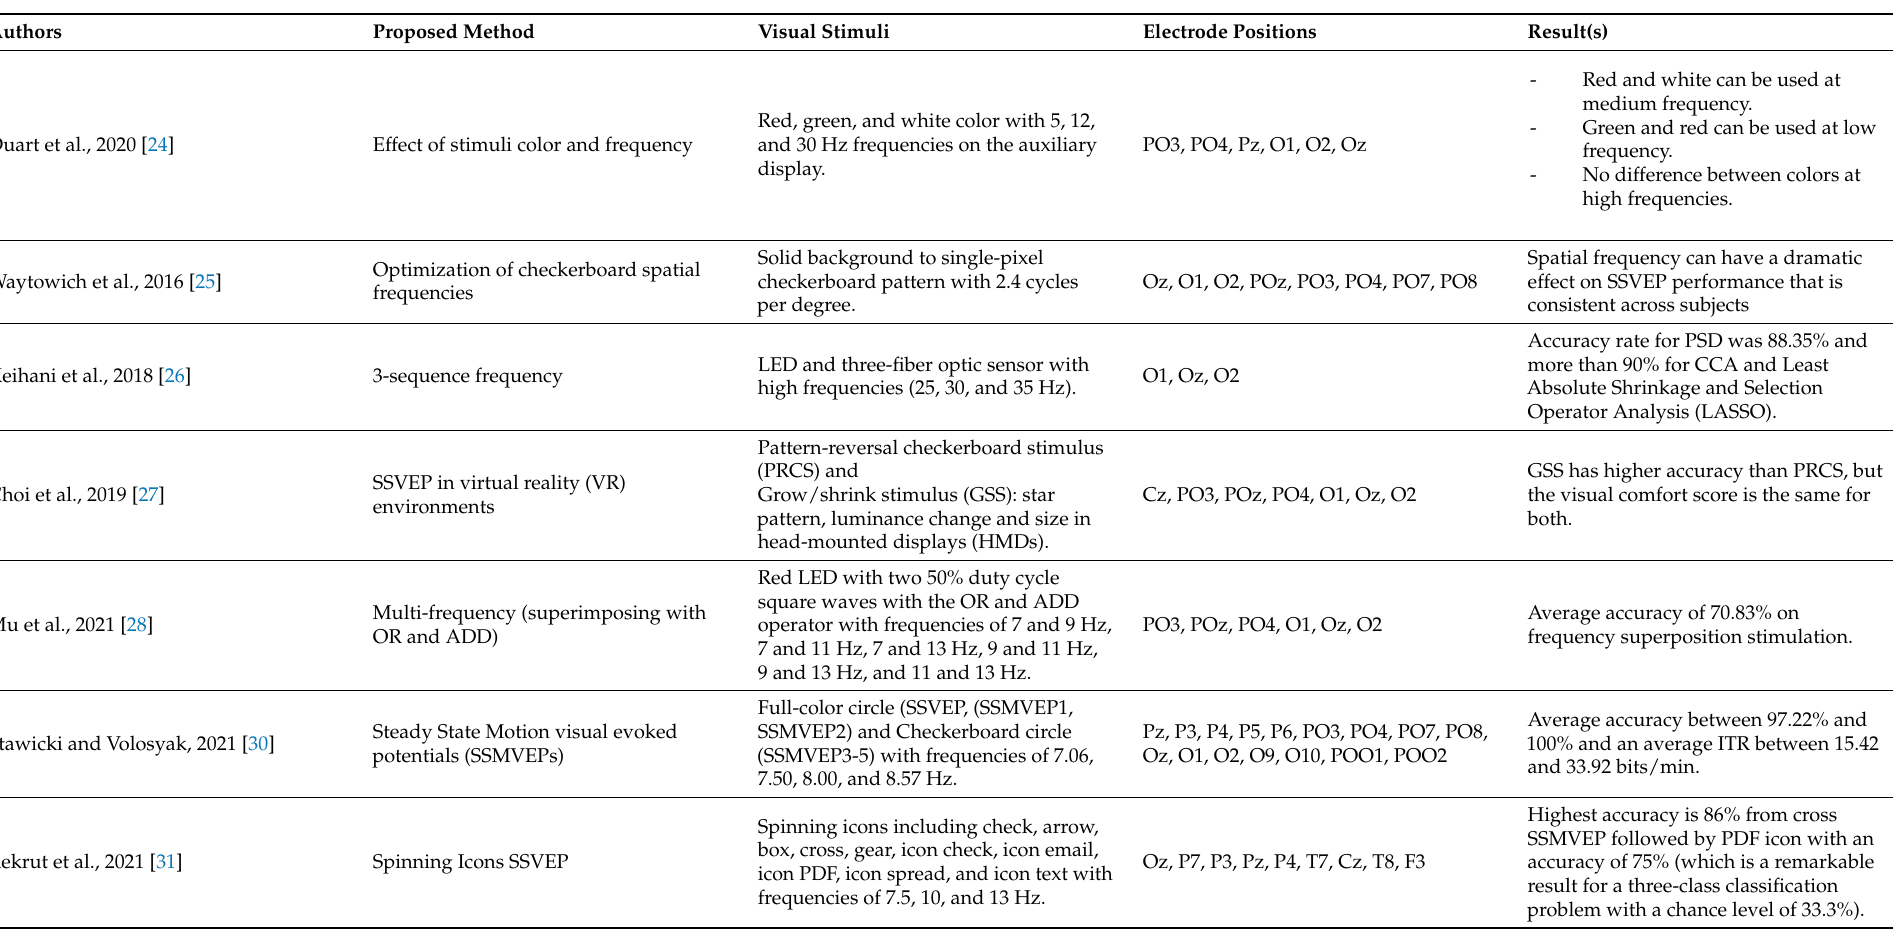
Table 1. Research studies on visual stimuli for SSVEP-based